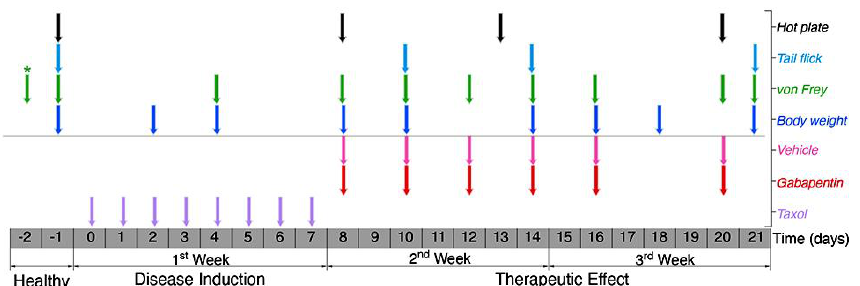
Figure 1. The schematic presentation of the TIPN study protocol. A TIPN was induced in mice (n = 40) by daily injection of Taxol from day 0 to 7 (1st week, disease induction) to a cumulative dose of 48 mg/kg. Gabapentin and vehicle saline were injected during the 2nd and 3rd week (therapeutic effect). The neuropathic pain was evaluated by measuring mechanical allodynia using the von Frey test in the healthy mice (two days (*) and one day before the first Taxol injection), for baseline response and during the disease and therapy period, and thermal hypersensitivity was measured four times each, with the tail-flick and the hot plate tests during the entire protocol. The body weight of animals was measured three times a week throughout the entire protocol. Healthy represents the mice cohort before TIPN. Colored arrows represent the day of drug delivery and performance of the neurobehavioral